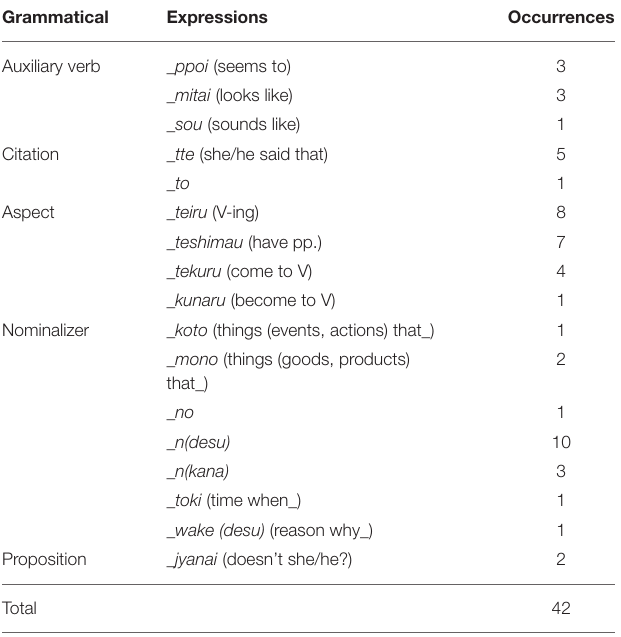
TABLE 4 | Modal markers for objectifying psychological